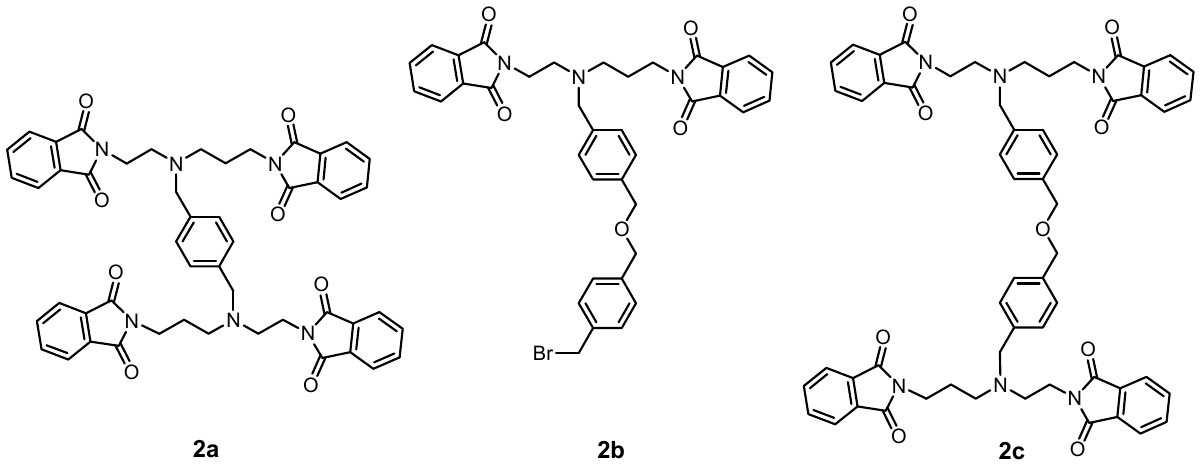
Figure 5. Suggested structures of species identified in the mass spectrum of the reaction mixture during the preparation of 2 . m/z values for 2a : 856.25 [M+H] + , 2b : 681.17 [M+H] + and 2c : 977.17 [M+H] + .